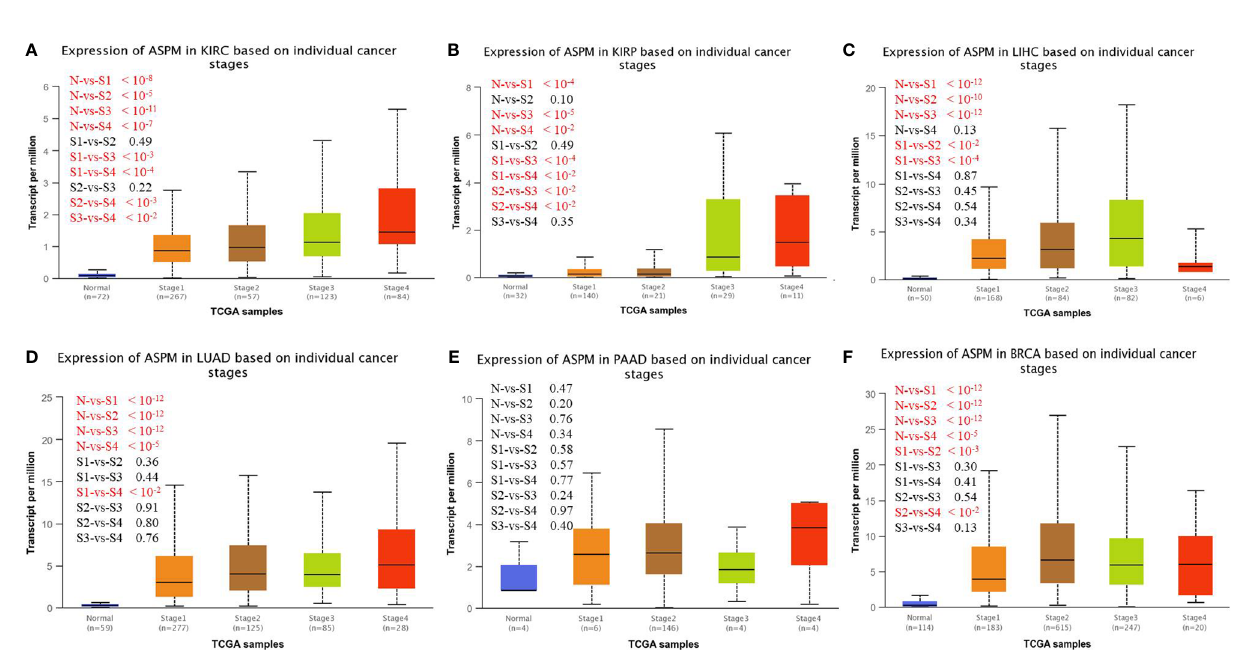
FIGURE 2 | UALCAN analysis for the correlation between ASPM mRNA expression level based on cancer stage. KIRC: Normal (n = 72), stage 1 (n = 267), stage 2 (n = 57), stage 3 (n = 123), stage 4 (n = 84); KIRP: Normal (n = 50), stage 1 (n = 168), stage 2 (n = 84), stage 3 (n = 82), stage 4 (n = 6); LUAD: Normal (n = 59), stage 1 (n = 277), stage 2 (n = 125), stage 3 (n = 85), stage 4 (n = 28); PAAD: Normal (n = 4), stage 1 (n = 6), stage 2 (n = 146), stage 3 (n = 4), stage 4 (n = 4); BRCA: Normal (n = 114), stage 1(n = 183), stage 2(n = 615), stage 3(n = 247), stage 4 (n = 20). (A) Expression of ASPM in KIRC based on individual cancer stages. (B) Expression of ASPM in KIRP based on individual cancer stages. (C) Expression of ASPM in LIHC based on individual cancer stages. (D) Expression of ASPM in LUAD based on individual cancer stages. (E) Expression of ASPM in PAAD based on individual cancer stages. (F) Expression of ASPM in BRCA based on individual cancer stages. n: Number of